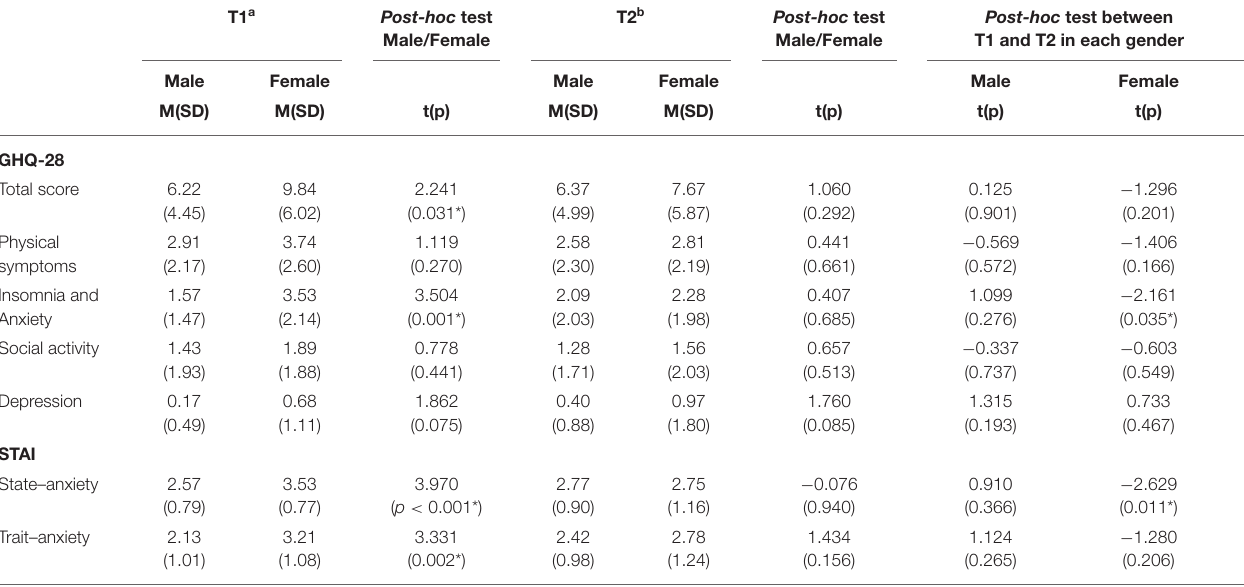
TABLE 2 | Group comparison by